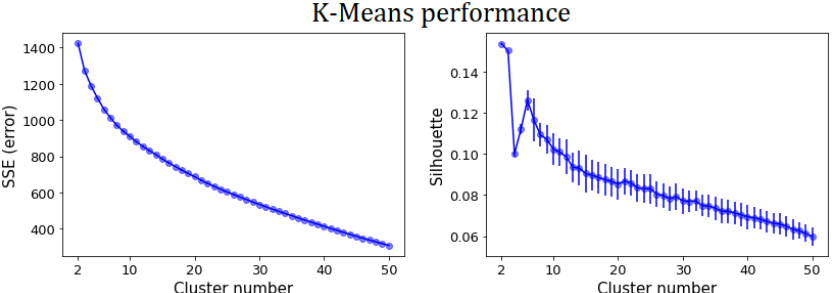
Figure 5. SSE ( left panel ) and mean Silhouette value ( right panel ) of K-means clustering for Startup- Blink countries at different fixed numbers of clusters. Error bars are determined by the variance of the considered quantities over 100 runs of the algorithm. The absence of an elbow-point in the SSE plot, along with the maximum mean Silhouette value obtained for k = 2, where SSE also reaches its maximum, implies that K-means is not well suited for an efficient partition of StartupBlink countries.